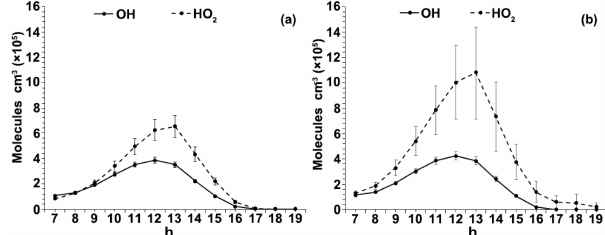
Figure 11. (a) Net production of OH and HO 2 by LPG-fueled ve- hicle exhaust (negative values indicate net destruction); and (b) in- creases of OH and HO 2 from the period before the program to dur- ing the